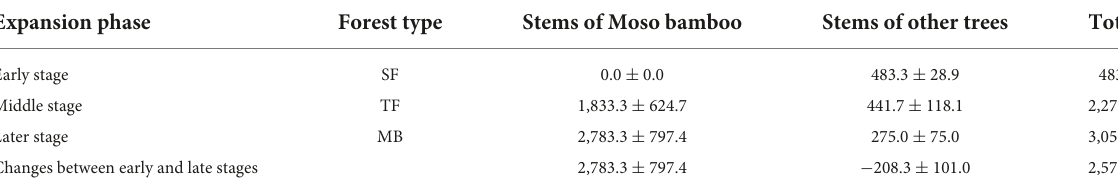
TABLE 2 Effect of Moso bamboo invasion on stem number [ind./ha; ( N = 3 in each group)].